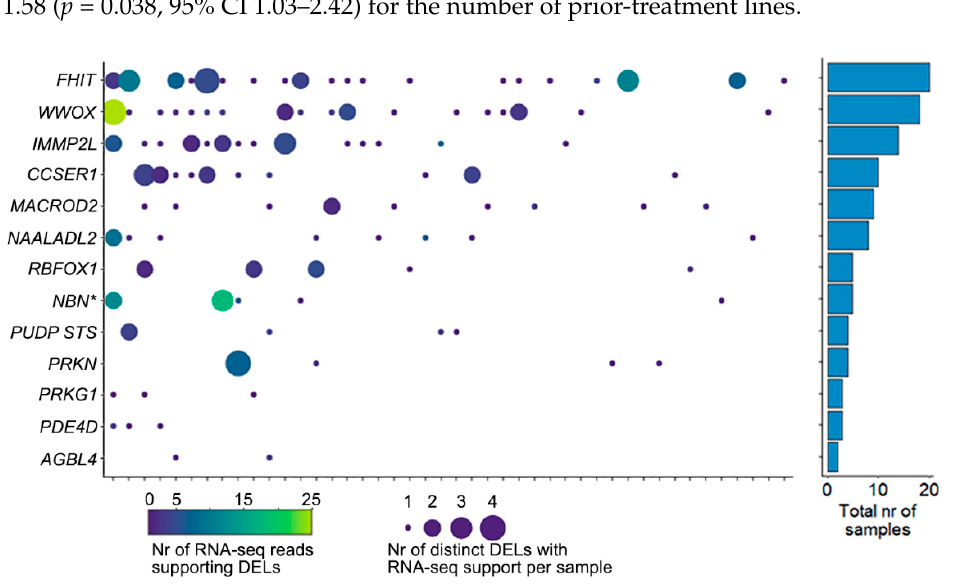
Figure 5. RNA-seq reads supporting DELs. The left panel shows the number of RNA-seq reads that support a DEL in one of the CFS regions. X-axis shows 44 samples, y-axis the 13 CFS regions (* indicates that NBN is the nearest gene). The color of the bubble indicates the total number of reads observed for all DELs in that sample/CFS region, and the size of the bubble indicates the total number of DELs with supporting RNA-seq reads in that sample/CFS region. The right panel shows the total number of samples that have RNA-seq support of DELs in the CFS region. Table 2. Patients treated with platinum-containing